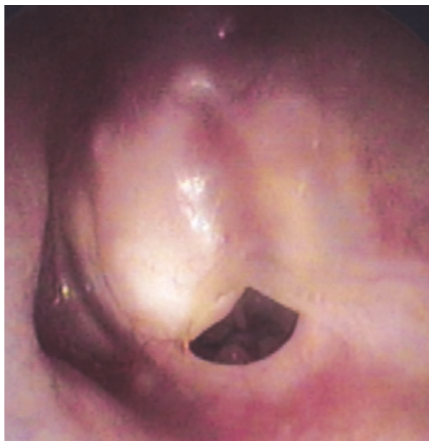
Figure 1: The left tympanic membrane is thick and white. A left tympanic membrane perforation is evident, but with no discharge.